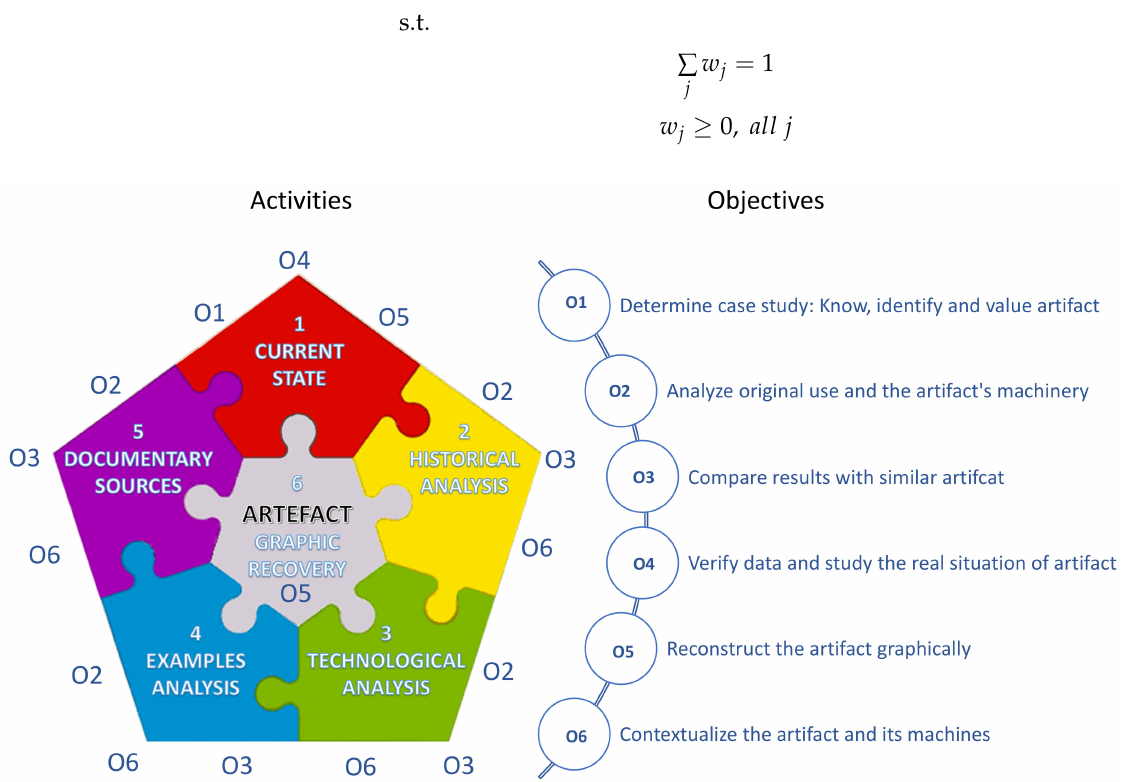
Figure 3. Main activities and objectives. Source: own elaboration.